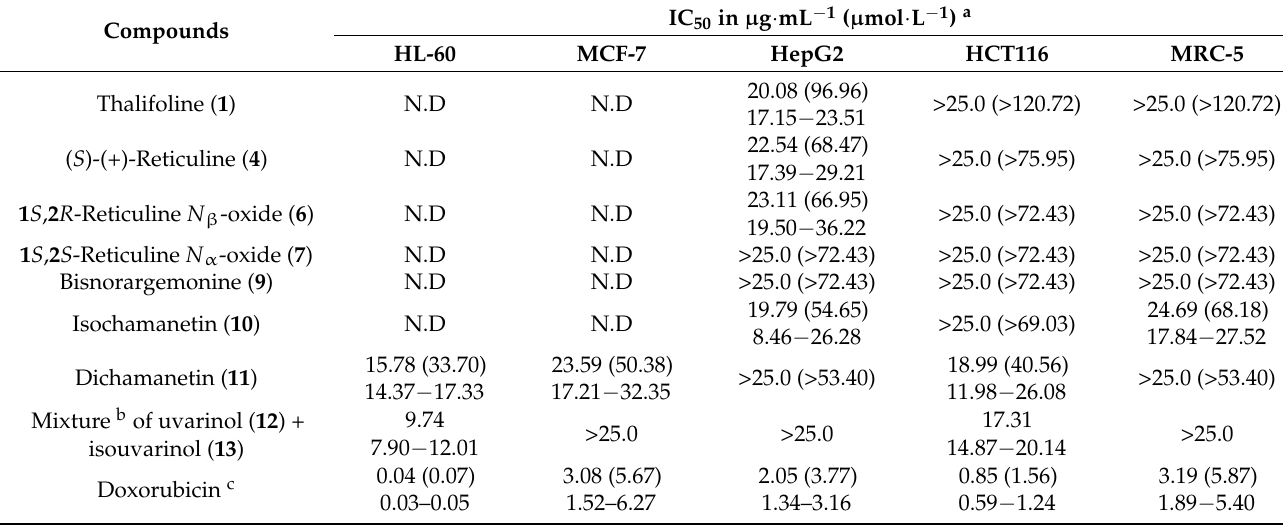
Table 2. Cytotoxic activity of the isolated compounds from the bark of D. calycina .